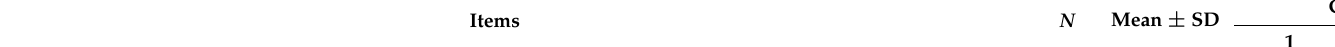
Component 1 2 3 4